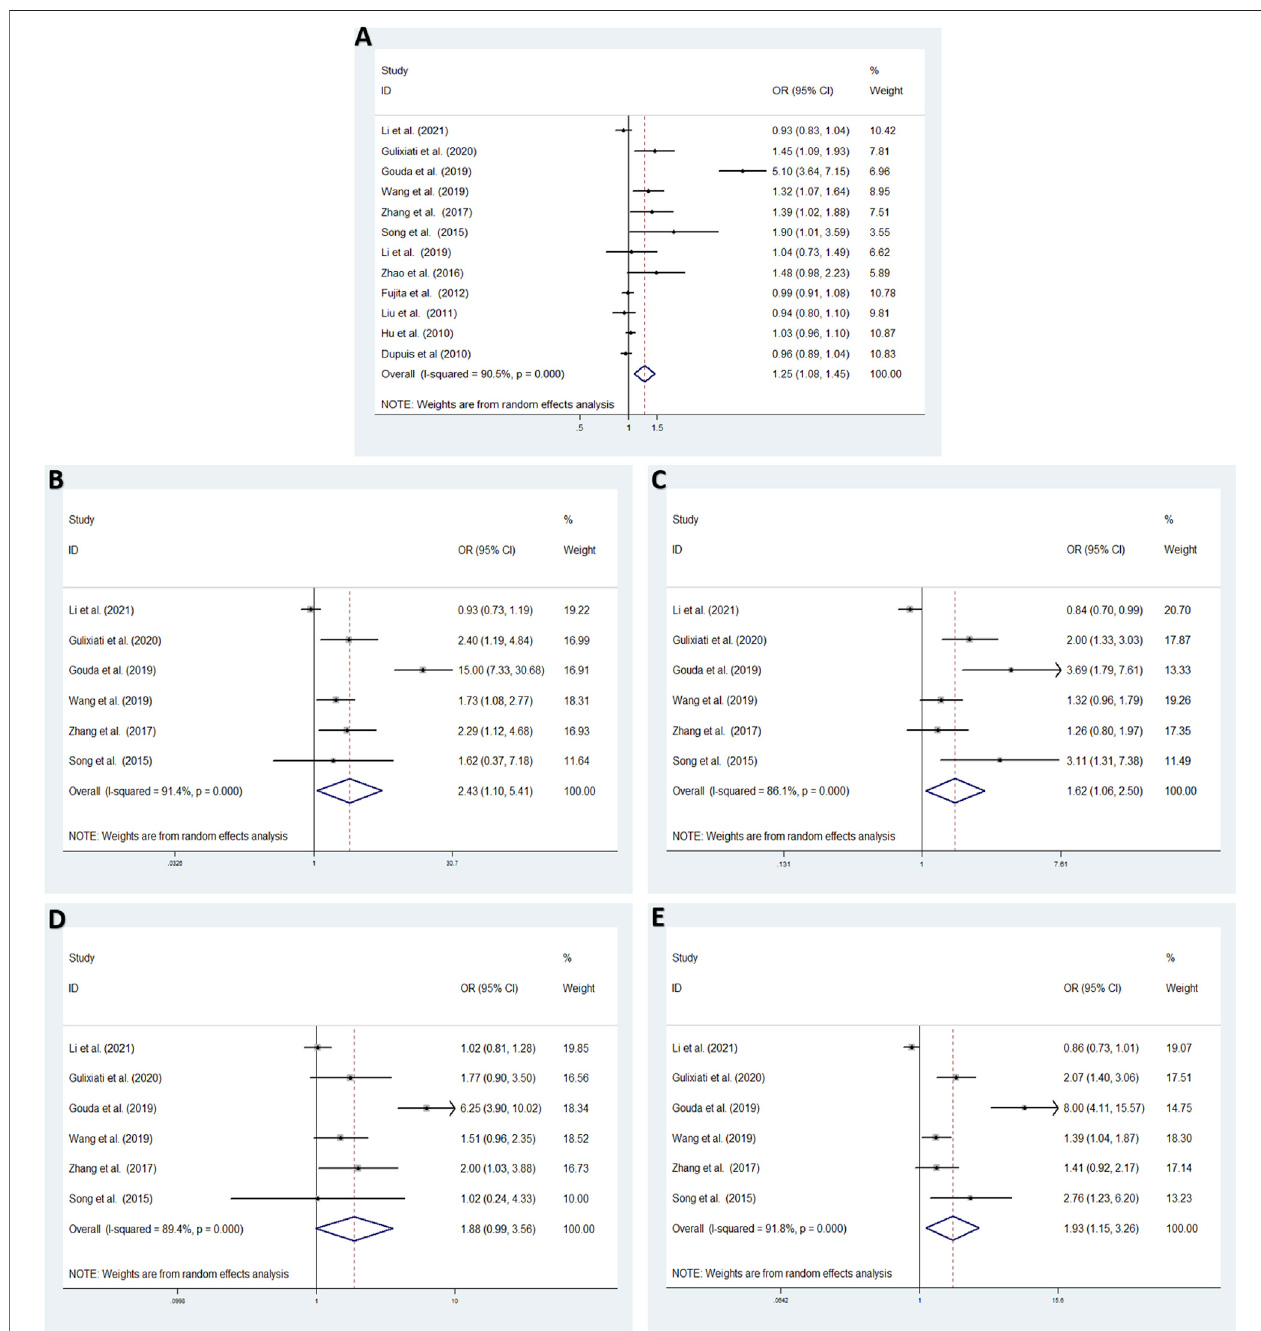
FIGURE2| Meta-analysis with a random effects model for the association between the IGF-1 rs35767 and T2DM susceptibility. (A) Allele model, T vs. C. (B) Additive model (homozygote comparisons): TT vs. CC. (C) Additive model (heterozygote comparisons): TC vs. CC. (D) Recessive model, TT vs. CC + CT. (E) Dominant model, TT + CT vs. CC. OR: odds ratio, CI: con fi dence interval, I-squared: measure to quantify the degree of heterogeneity in meta- analyses.